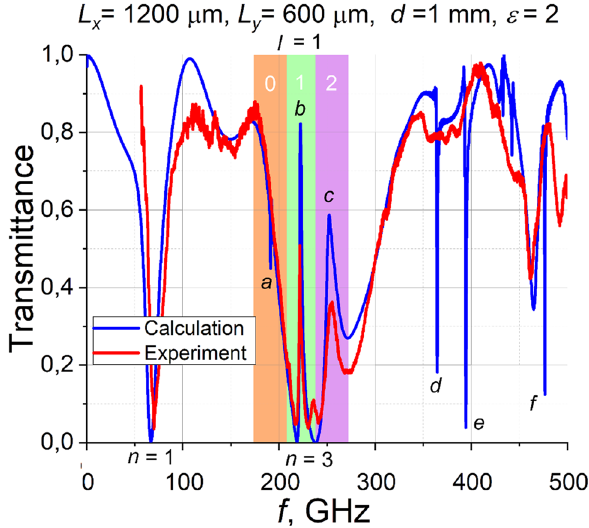
Figure 6. Measured and calculated dependences of transmittance of mirrored SRR on a 1 mm thick PTFE substrate. Letter n denotes plasmonic mode number, different colors mark different waveguide modes, numbers in a colored background correspond to waveguide mode, and letter l stands for diffraction order. Letters a, b, and c denote Fano